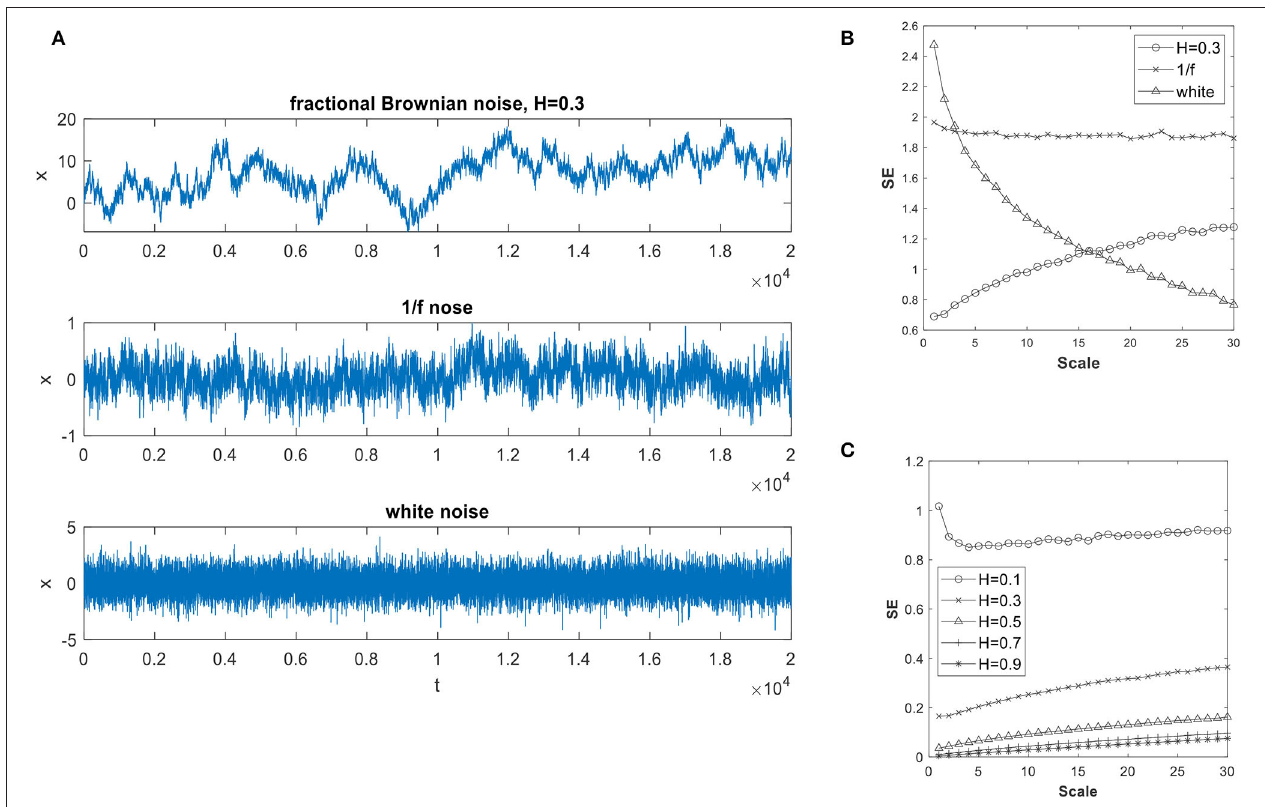
FIGURE 1 | (A) Sample time series generated with Fractional Brownian noise, 1/f noise and white noise; (B) Variation of sample entropy with scales of the three time series; and (C) How the Hurst index of a fractional Brownian noise affects sample